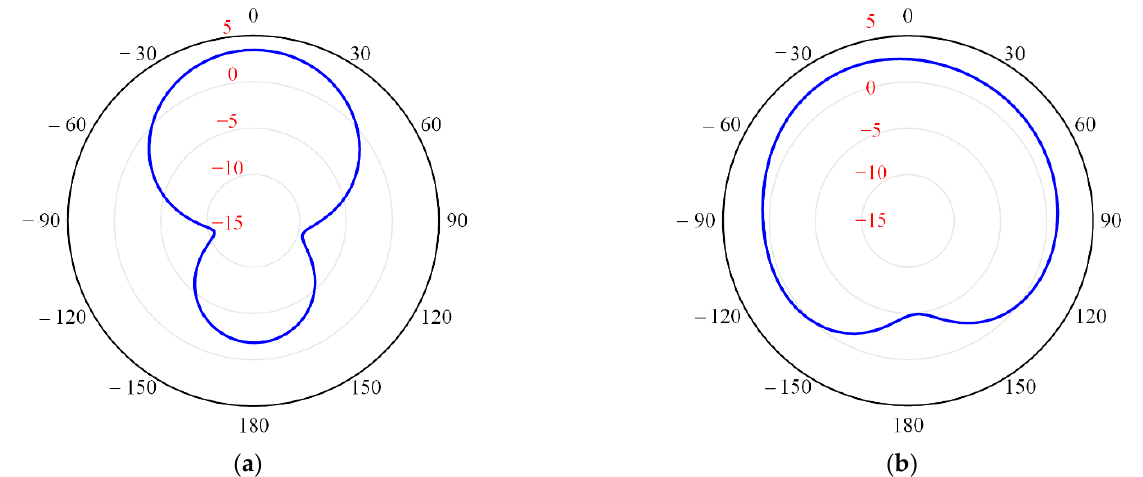
Figure 13. 3D radiation patterns of the dual-band slotted square patch antenna at ( a ) 2.4 GHz and ( b ) 2.8 GHz.